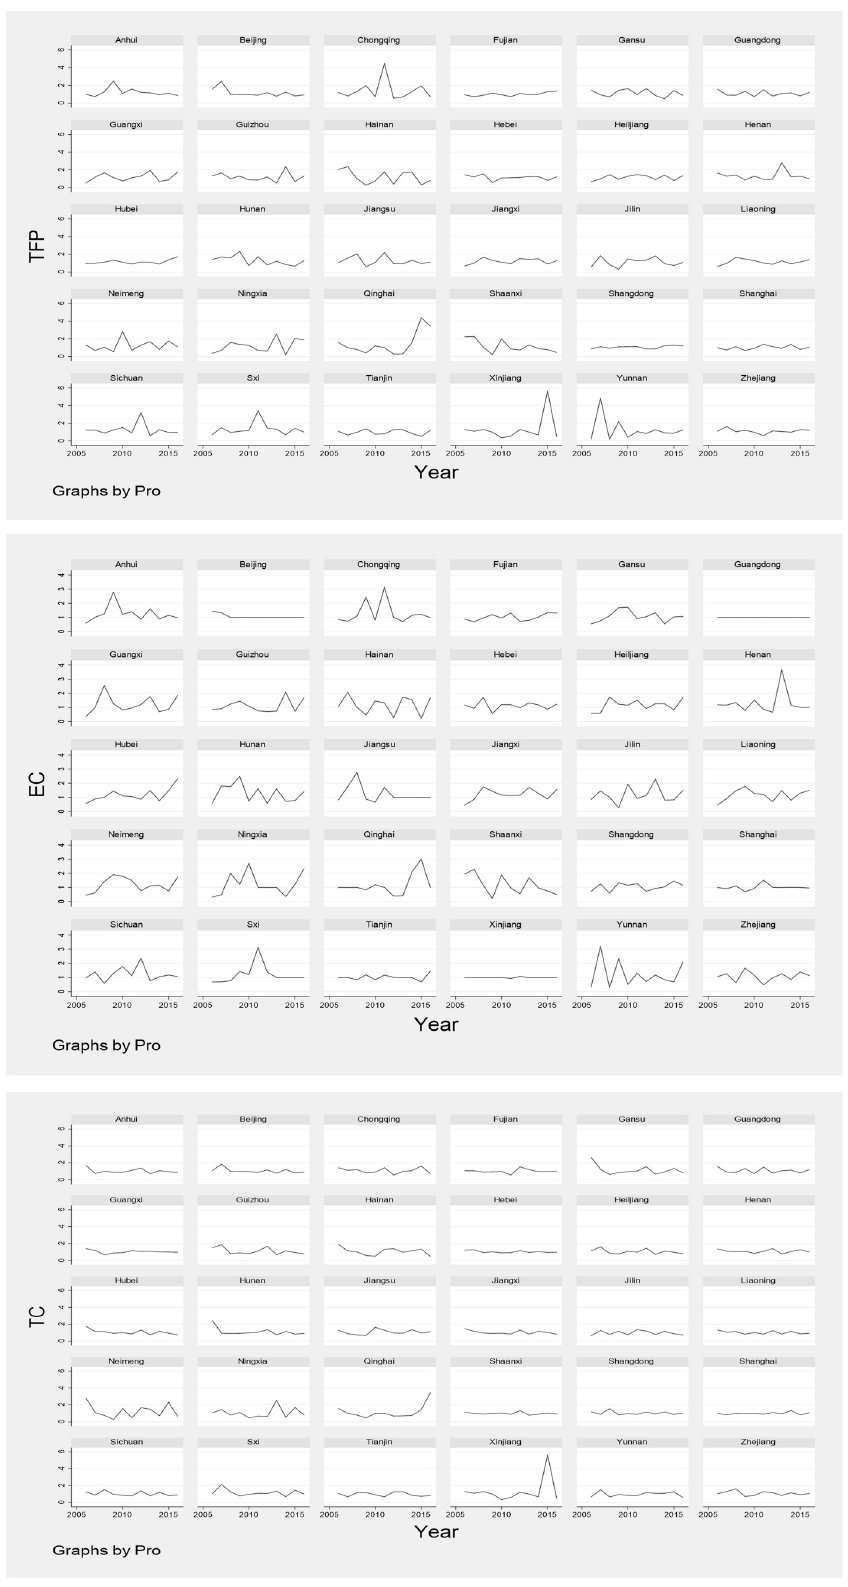
Fig 2. The variation trend of TFP and its decomposition index. https://doi.org/10.1371/journal.pone.0264017.g002 PLOS ONE | https://doi.org/10.1371/journal.pone.0264017 May 10,